Question: Condense the content of this figure into a single sentence.
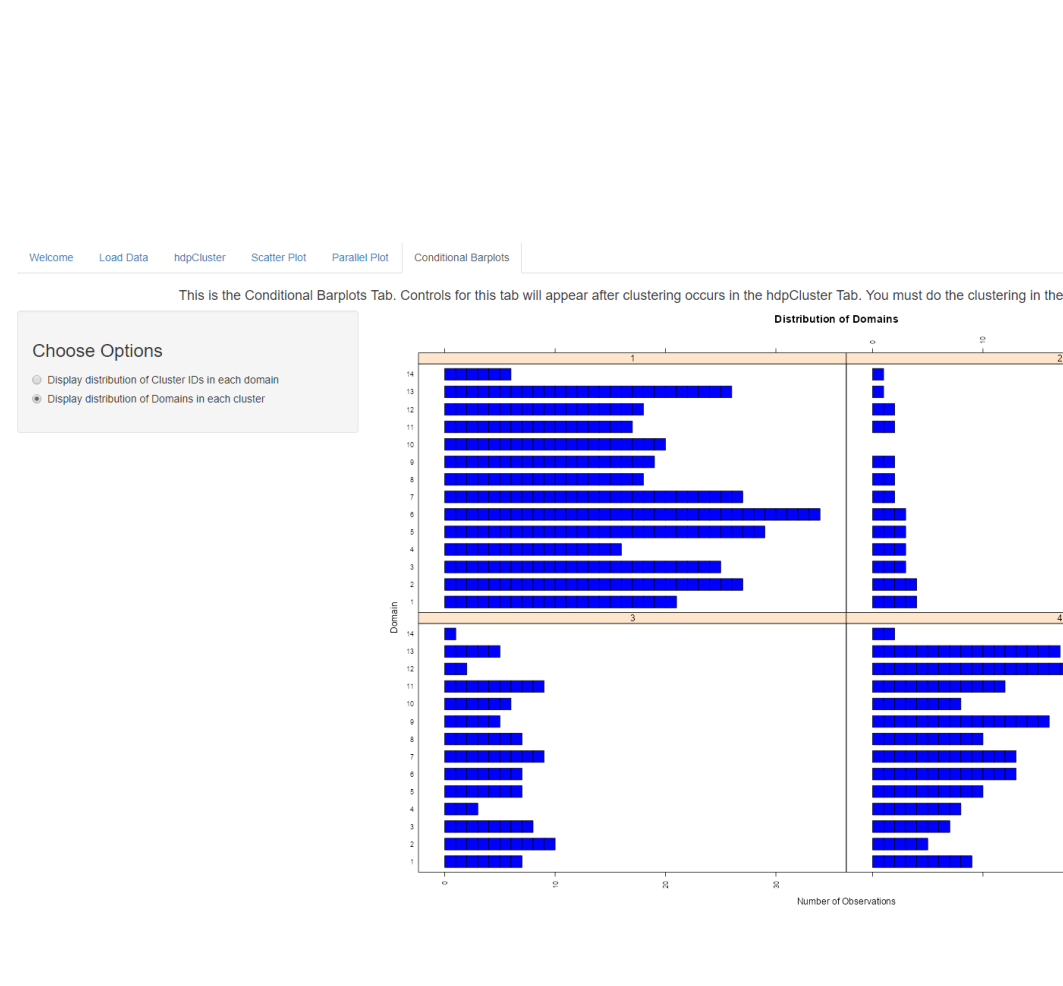
Answer: This is a screenshot of the hdpGrowclusters application Conditional  Barplot tab. When the second button is selected, we see the distribution of domains in each  cluster.